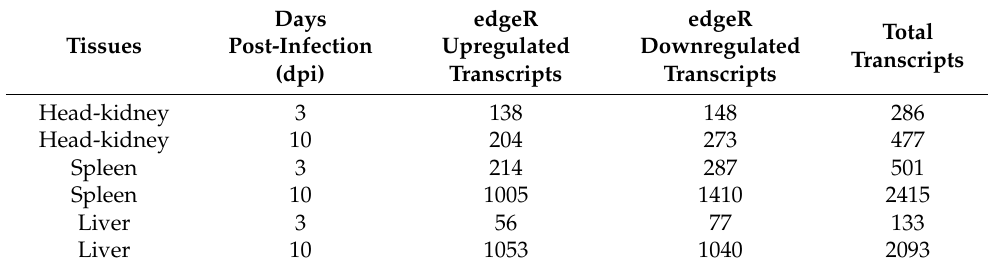
Table 3. Differentially expressed transcripts (DET) identified by de novo transcriptome analysis.